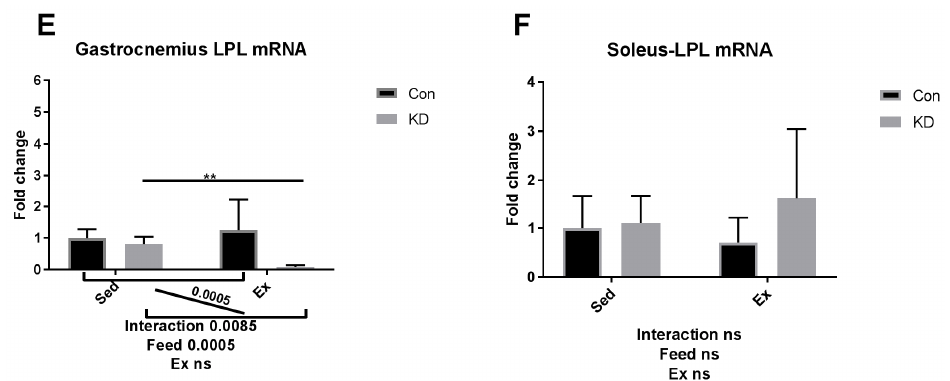
Figure 6. mRNA expression of lipolytic enzymes immediately after exhaustion in gastrocnemius ( A , C , E ) and soleus ( B , D , F ). ATGL: adipose triglyceride lipase. HSL: hormone-sensitive lipase. LPL: lipoprotein lipase. * p < 0.05 and ** p < 0.01. Significance between groups are marked using slashes.